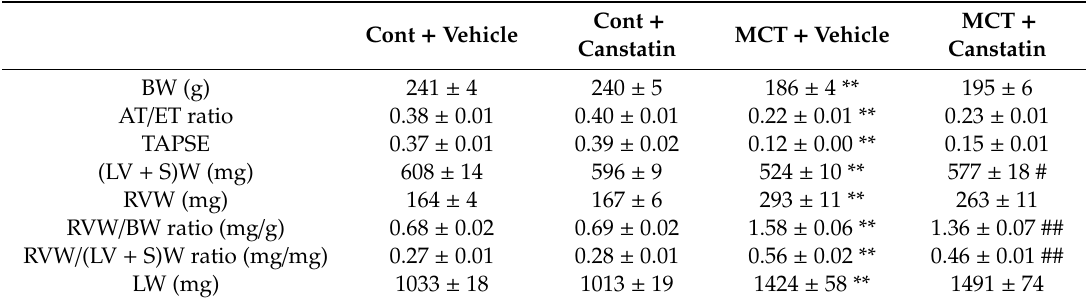
Cont + vehicle: vehicle-administered Cont, Cont + canstatin: canstatin-administered Cont, MCT + vehicle: vehicle-administered MCT, MCT + canstatin: canstatin-administered MCT, TAPSE: tricuspid annular plane systolic excursion, (LV + S)W: left ventricular plus interventricular septum weight. The data are shown as mean ± S.E.M. (Cont + vehicle: n = 9, Cont + canstatin: n = 9, MCT + vehicle: n = 9, MCT + canstatin: n = 8). ** p < 0.01 vs. Cont + vehicle; #, ## p < 0.05, 0.01 vs. MCT + vehicle (one-way ANOVA followed by Bonferroni’s post-hoc